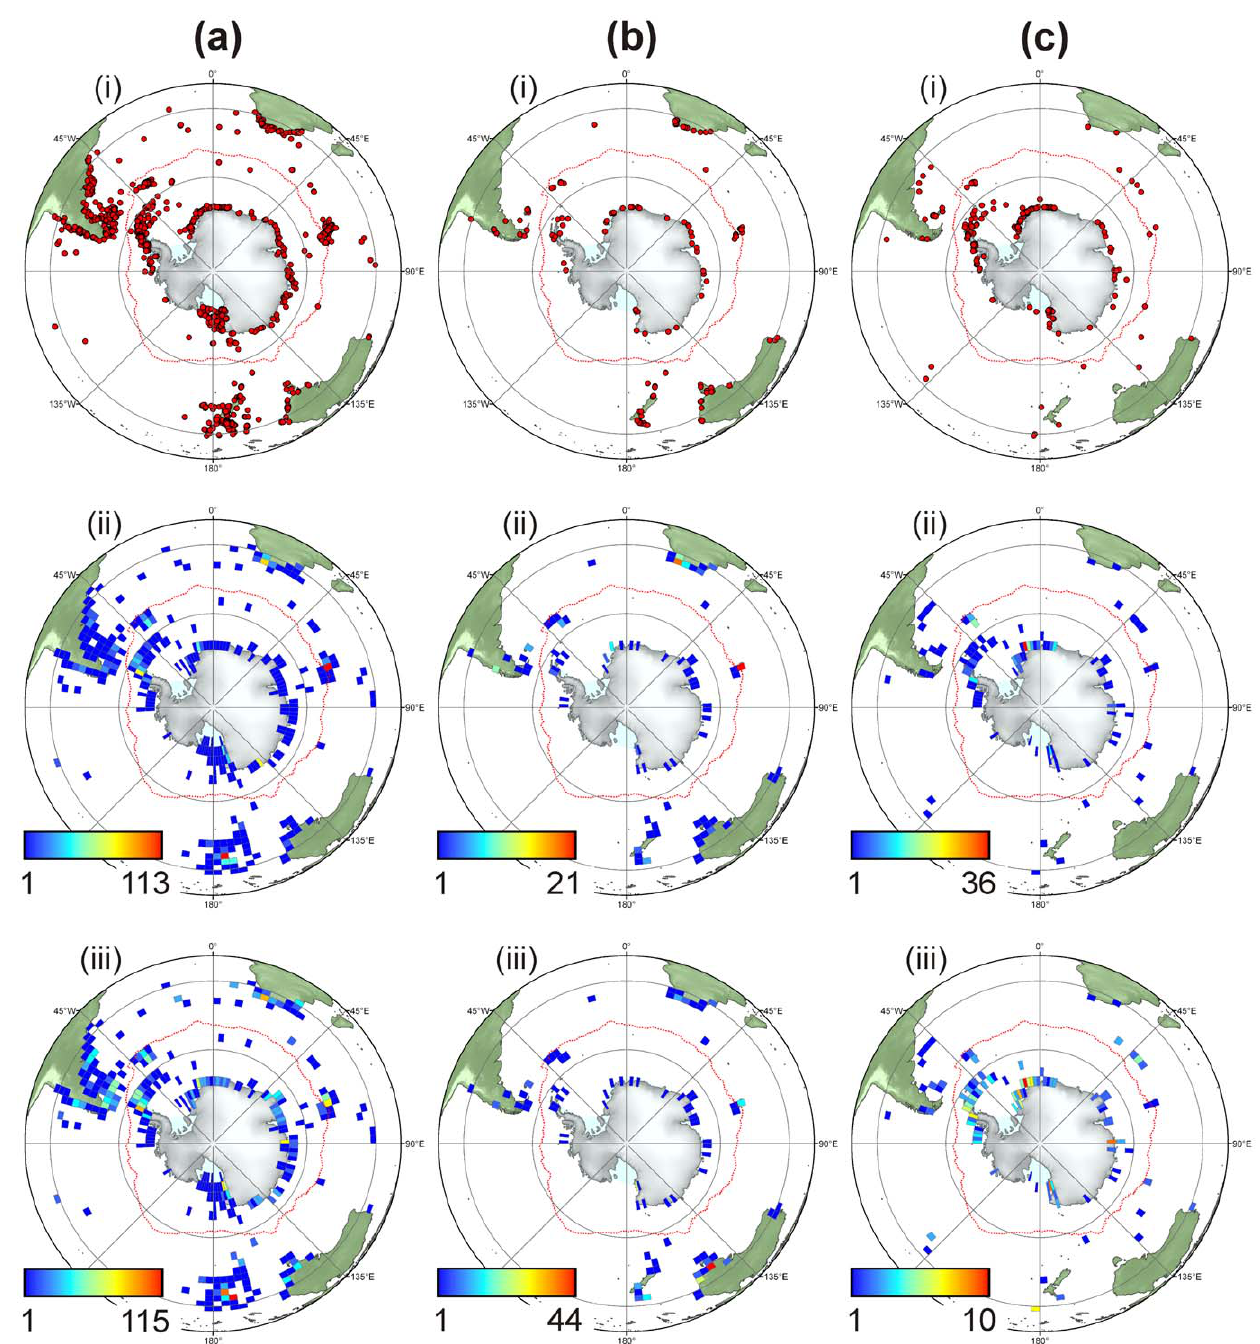
Figure 2. Quantifying the distribution of sponges within the Southern Ocean and neighbouring regions. Maps include three classes of Porifera (Demospongiae (ai–iii), Calcarea (bi–iii), and Hexactinellida (ci–iii)). (i) The distribution of sample locations for each class of sponge. (ii) The number of unique sample stations in a 3 u by 3 u grid cell for each class of sponge. (iii) The number of species collected from each 3 u by 3 u grid cell for each class of sponge. doi:10.1371/journal.pone.0041672.g002 which indicates limited eurybathy. Eighty-eight percent of Calcarea species were restricted to the shelf, and 6% were only found shallower than 100 m, with only 6% found in more than one bathymetric zone.